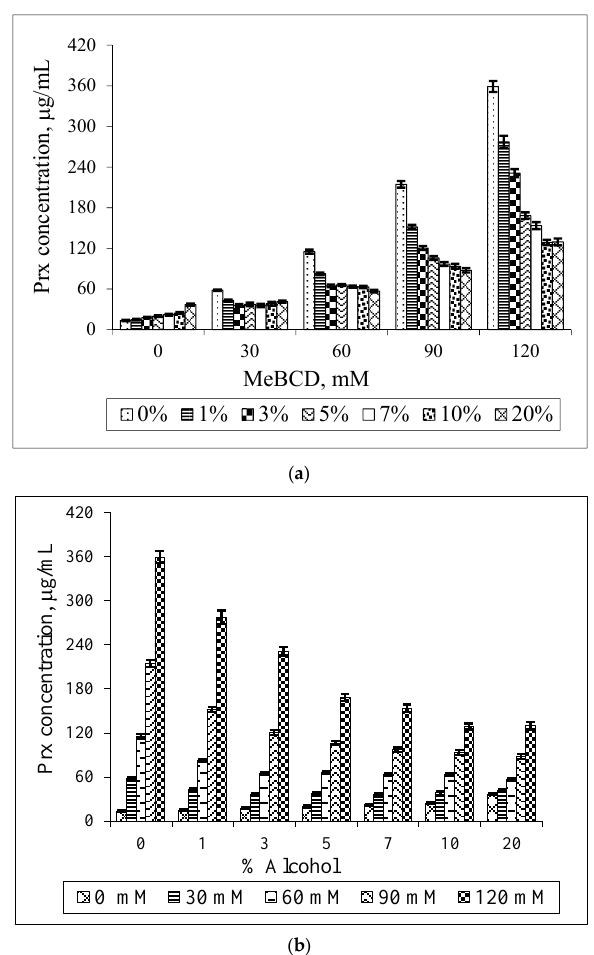
Figure 7. Effect of MeBCD concentrations on the solubility of Prx in Prx–MeBCD–ethanol ternary mixtures varying the percentage of ethanol ( a ); effect of ethanol on the solubility of Prx in Prx–MeBCD–ethanol ternary mixtures varying MeBCD concentrations ( b ).